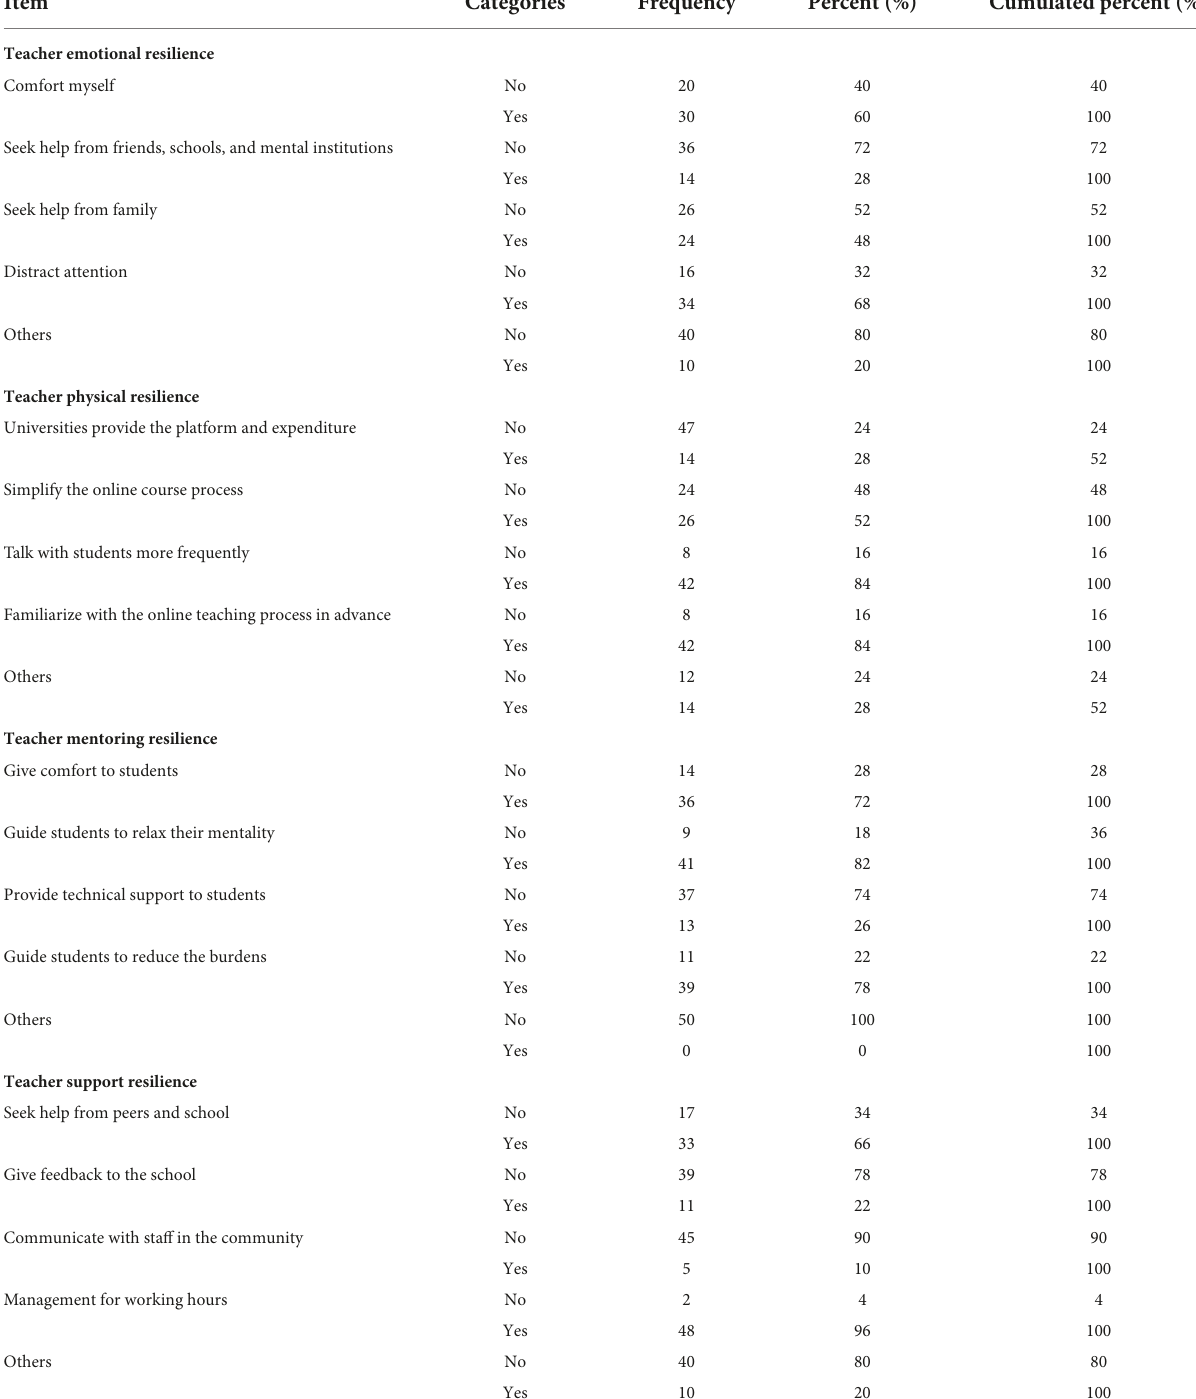
TABLE 3 Basic description of the teacher beliefs about